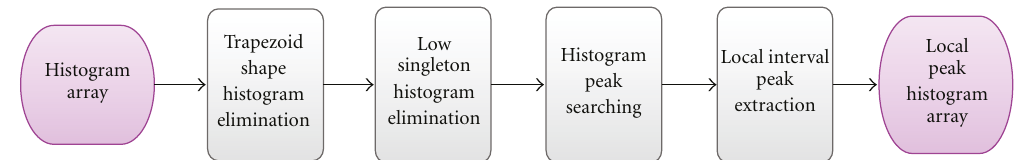
Figure 15: The flow chart of histogram postprocessing.